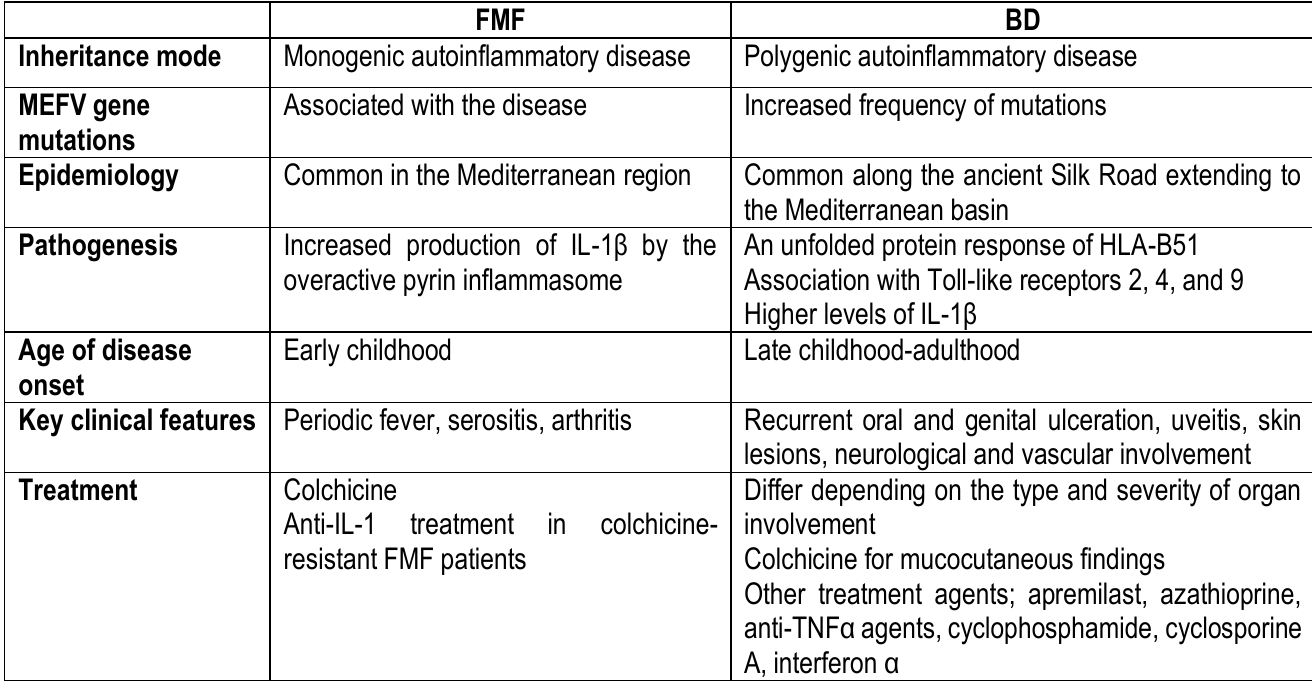
Table 1. Distinguishing features of FMF and